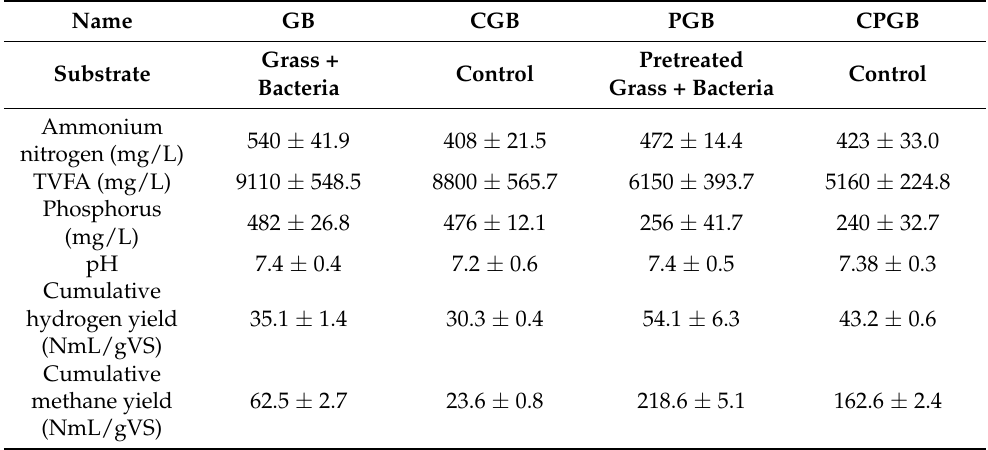
Figure 2. Cumulative hydrogen and methane production for AD pretreated grass with bacteria with control sample (PGB and CPGB, respectively: B , C ) and raw grass with bacteria with control sample (GB and CGB, respectively: A , D ) at 55 °C. Table 1. Concentrations of TVFA, ammonium nitrogen, orthophosphates (PO4 − 3), and pH in the digestates from the experiments. PGB—pretreated grass with bacteria; CPGB—control sample for PGB; GB—raw grass with bacteria; CGB—control sample for